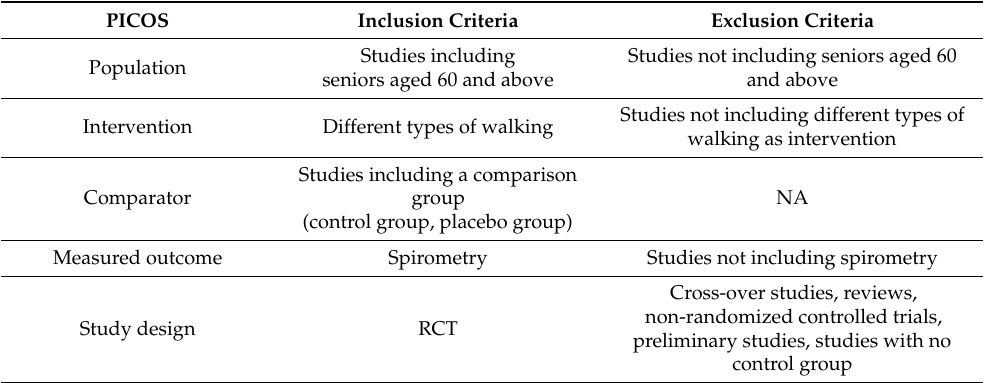
Table 2. Eligibility criteria for study